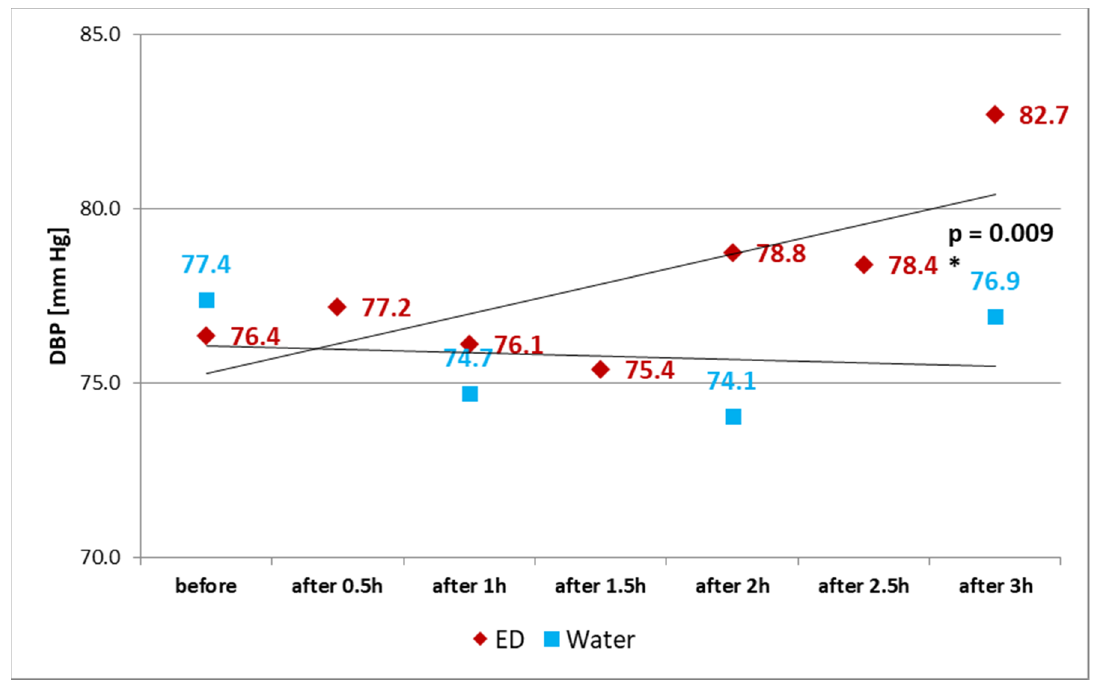
Figure 2. Changes in DBP after consuming EDs and water. * Statistical significance (at p < 0.05) between ED and water. DBP—diastolic blood pressure.